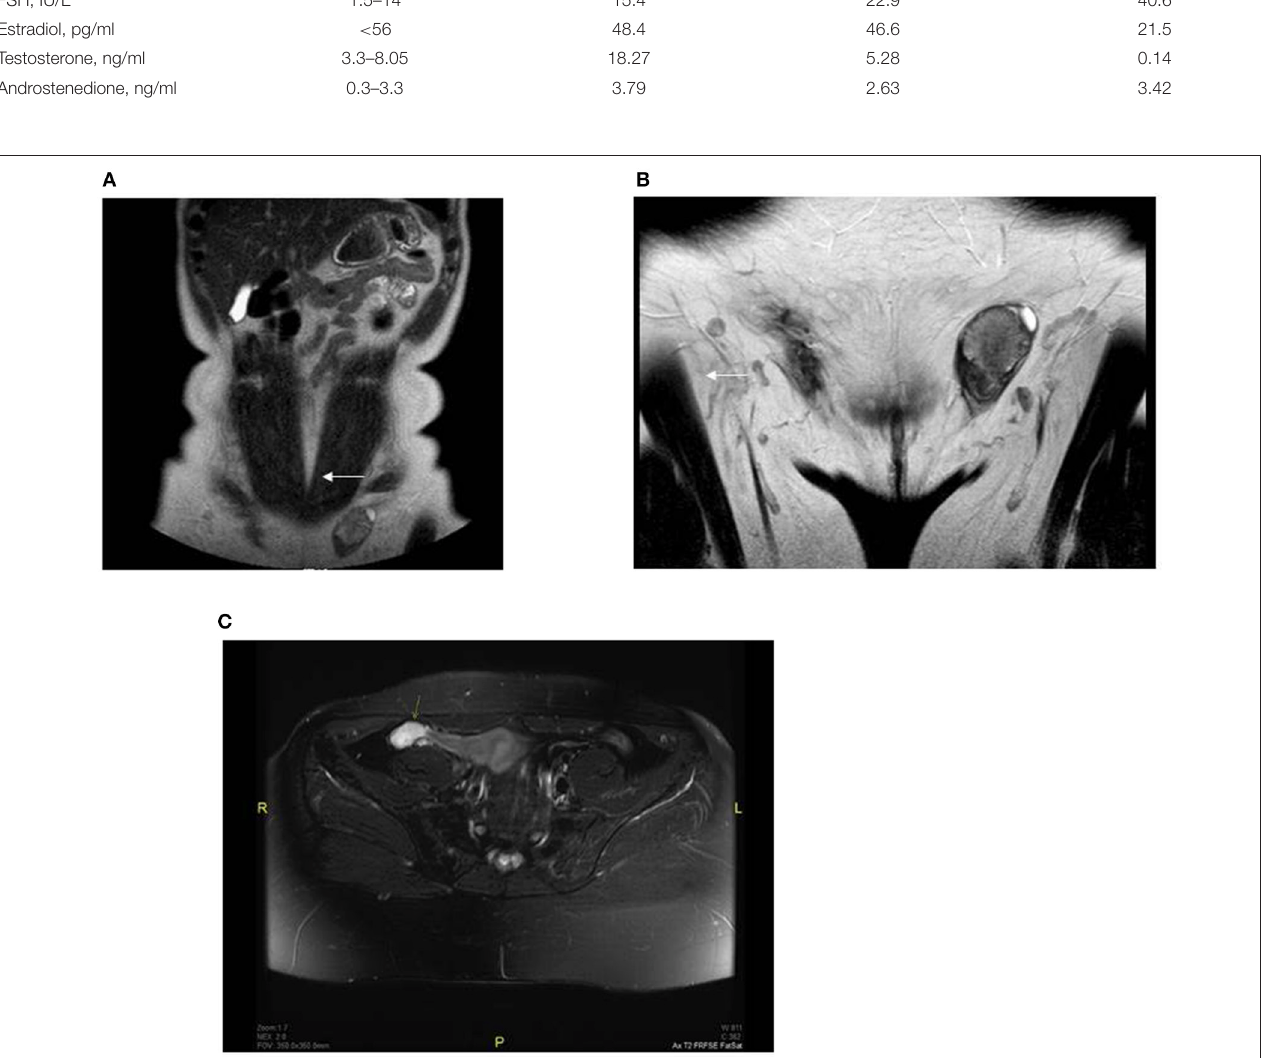
FIGURE 1 | Preoperative MRI revealed oval structures without follicular activity: (A) right side (showed with an arrow) − 1 × 1.3cm, located near the anterior abdominal wall; (B) left side (showed with an arrow) − 2.6 × 1.6cm, located in the left inguinal canal; (C) pelvic MRI fat-suppressed T2 sequence of the right hypogastrium with a residual testicular structure 1.2 × 2.4 × 3.3cm (showed with an